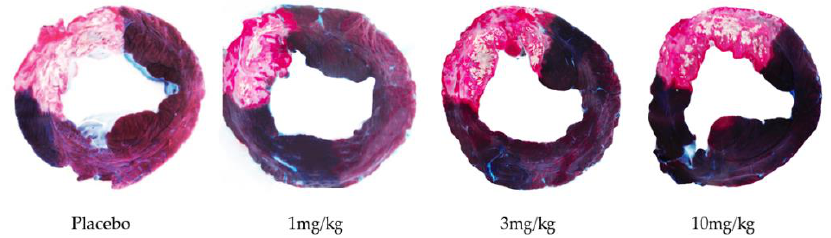
Figure 5. Representative pictures of basal slices of the different treatment groups (placebo, 1 mg/kg IZD334, 3 mg/kg IZD334, and 10 mg/kg IZD334. The dark area represents the remote area, the AAR is stained red, and the infarcted myocardium is stained white/pale.